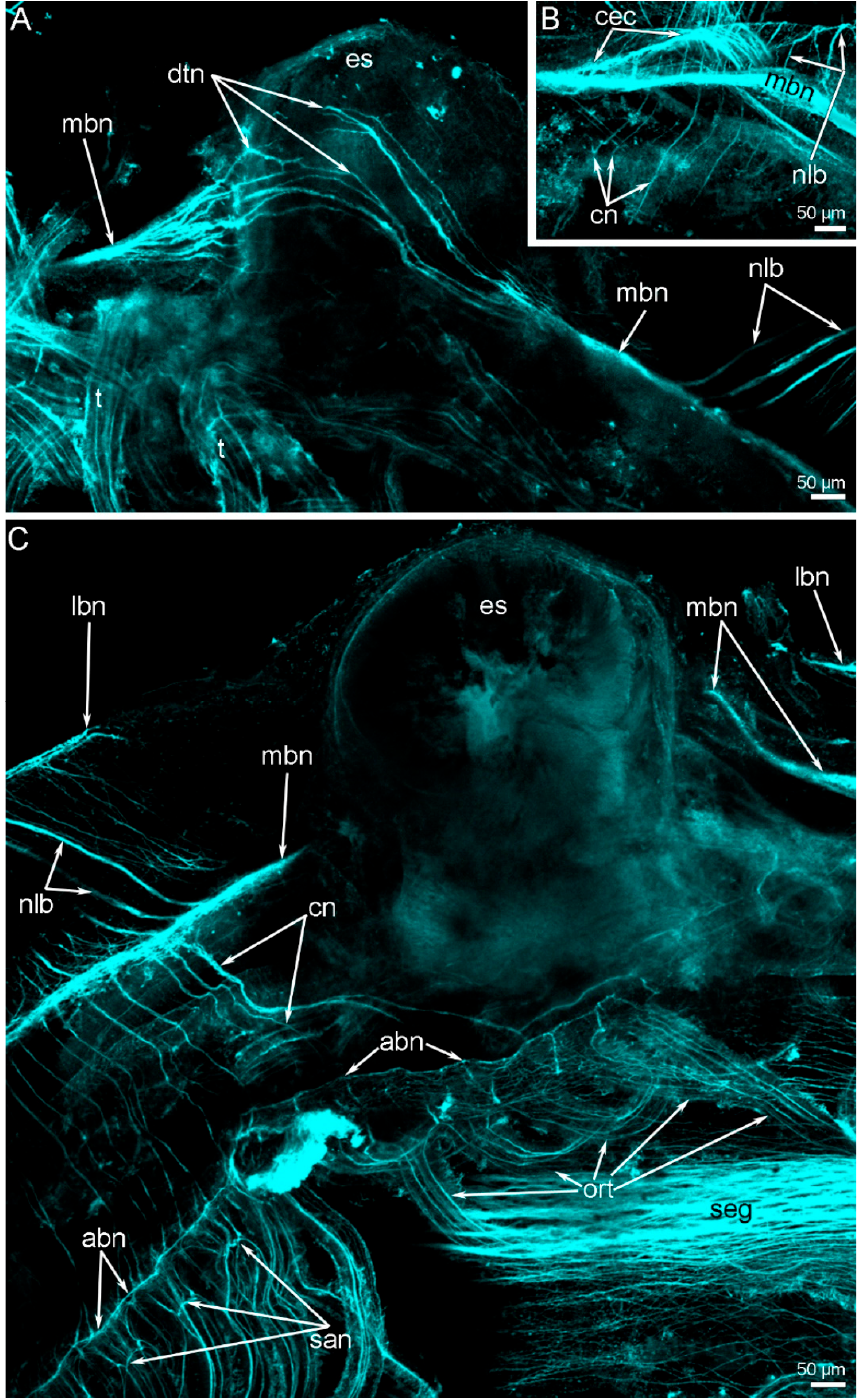
Figure 4. Organization of the nervous system in the oral region of Novocrania anomala adults. Z-projections after immunostaining against acetylated alpha-tubulin (cyan). ( A ) The dorsal view of the esophagus: supraenteric ganglion is absent; main brachial nerves of two arms are connected via dorsal thin neurites. ( B ) The base of the lophophore arm: circumenteric connective extends from the main brachial nerve. ( C ) Ventral view of the esophagus and oral area with the single row of oral tentacles. Abbreviations: abn—accessory brachial nerve; cec—circumenteric connective; cn—cross nerve; dtn—dorsal thin neurites; es—esophagus; lbn—lower brachial nerve; mbn—main brachial nerve; nlb—nerve of the lophophore base; ort—oral tentacles; san—second accessory brachial nerve; seg—subenteric ganglion.